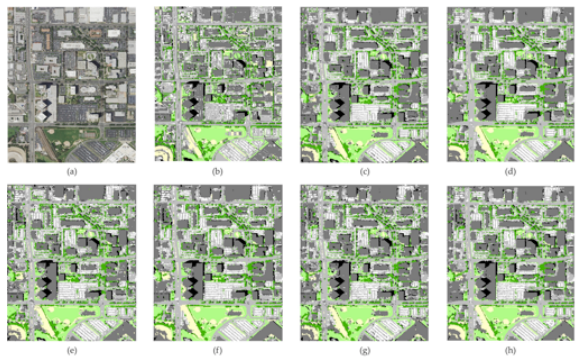
Figure 9. Classification result comparison of different methods for Urban scene. (a) Original image (b) OBIA-SVM; (c) Per- pixel SCNN; (d) Per-pixel MCNN; (e) SLICO based SCNN; (f) SLICO based MCNN; (g) SEEDS based SCNN; (h)SEEDS